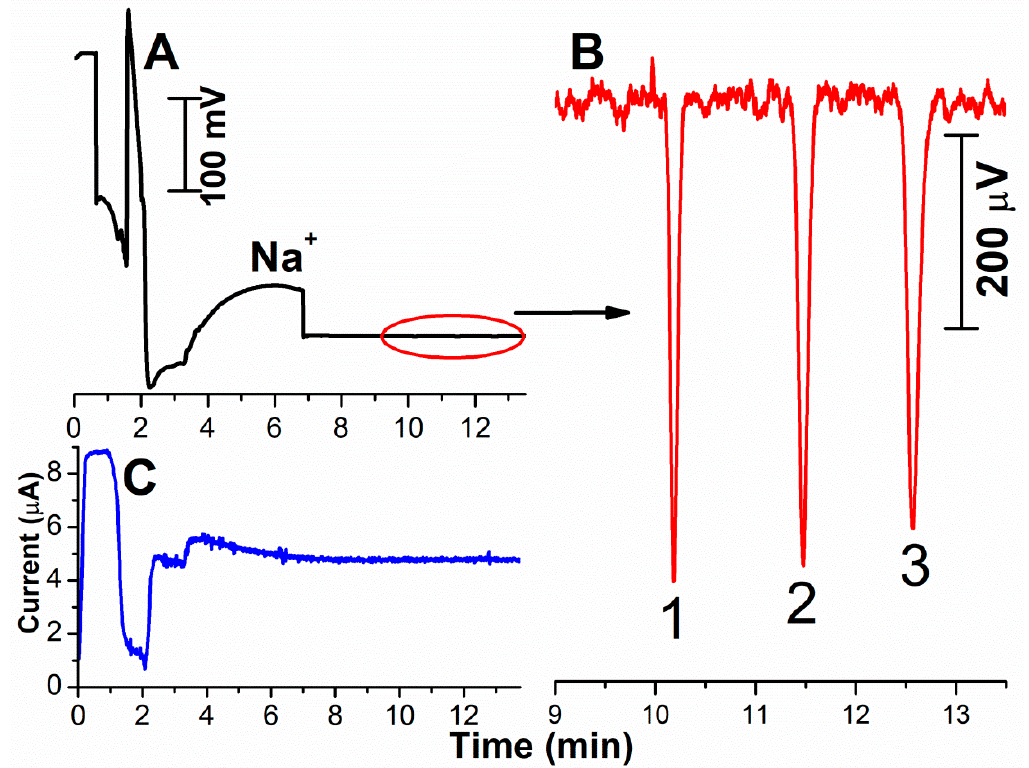
Figure 2. Complete recording of the stacking of the model sample (0.1 µM MMA, ADMA and SDMA in an ACN/infusion solution of 3:1), with filling 94.5% of the capillary with the sample ( A ); ( B )—detailed recording of the separation of 0.1 µM methylarginines; ( C )—variation of the electric current. Peak identification: 1—MMA; 2—ADMA; 3—SDMA.